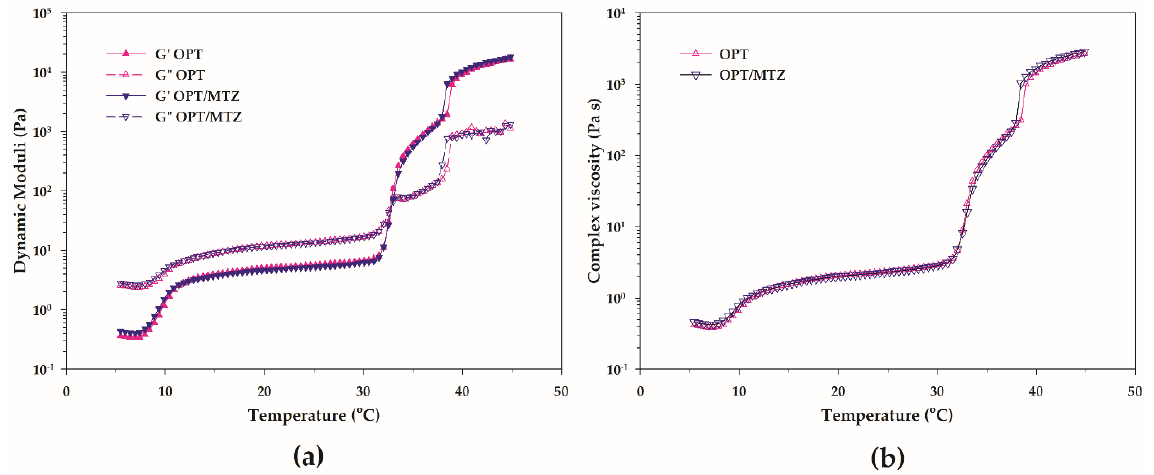
Figure 6. The temperature-dependent rheological characteristics of OPT and OPT/MTZ: ( a ) the plots of dynamic moduli as a function of temperature and ( b ) the plots of complex viscosity as a function of temperature.